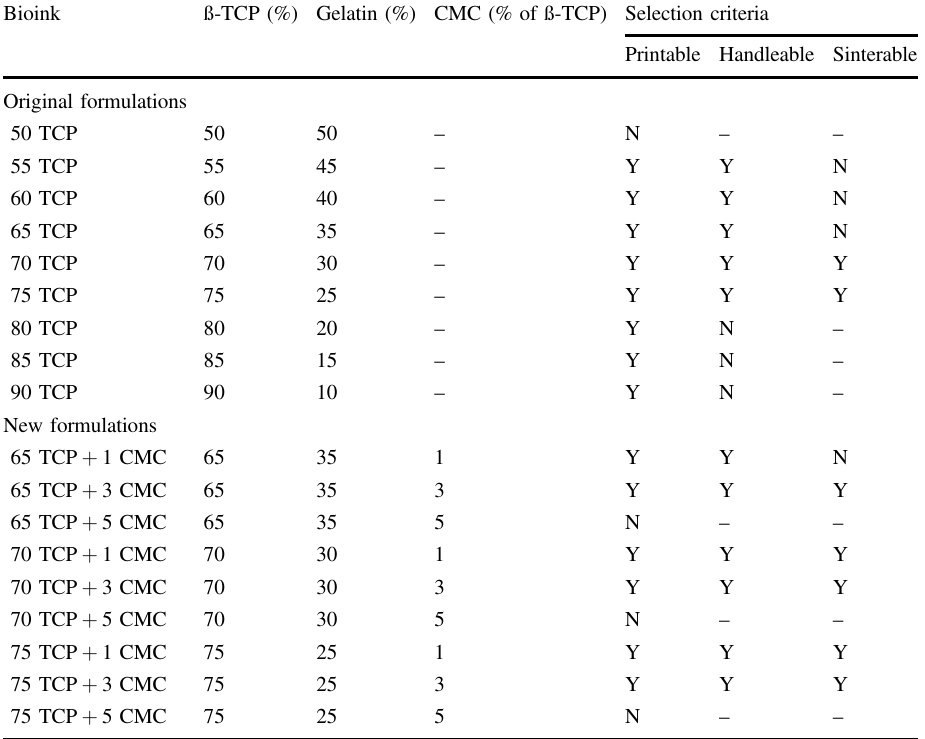
Table 1 Summary of the bioink compositions and the selection criteria used in the present study